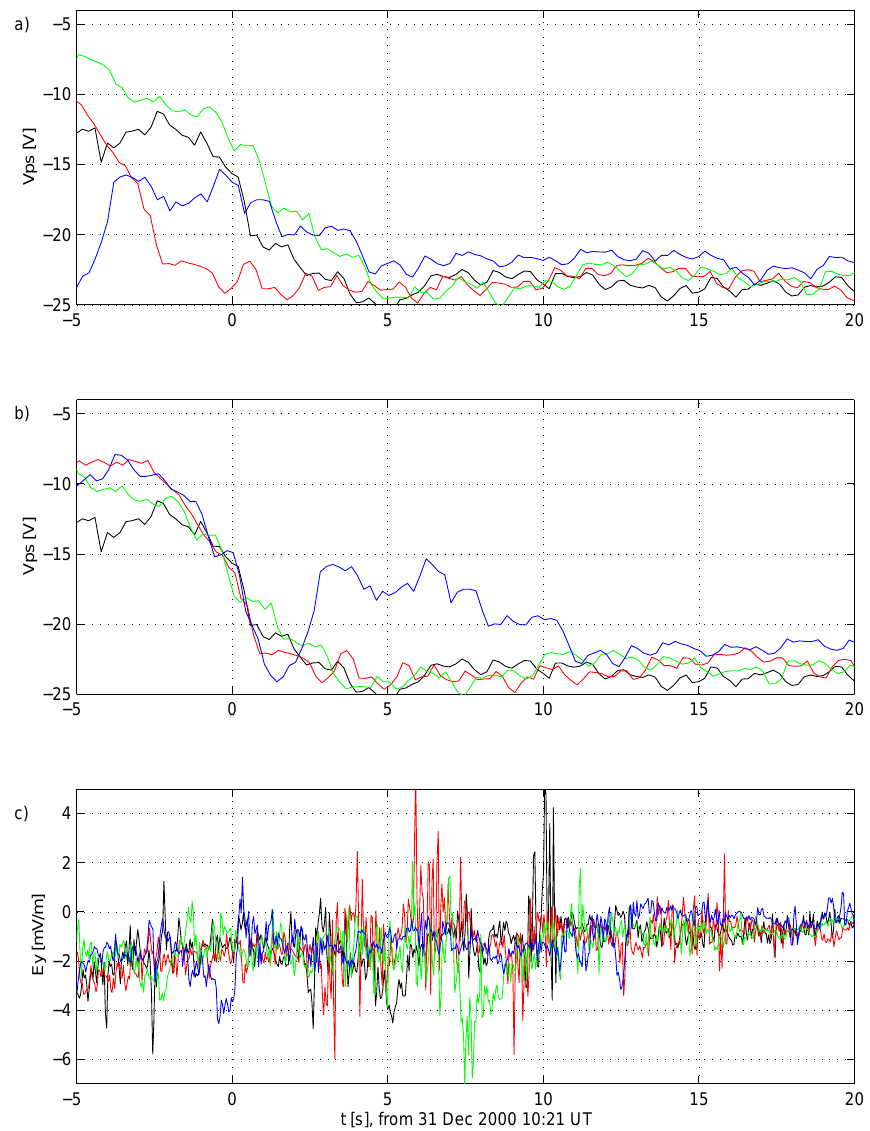
Fig. 8. (a) The potential v ps from 10:21:00 UT on 31 Decemeber 2000, for all four Cluster satellites (1: black; 2: red; 3: green; 4: blue), (b) The same signals, but shifted in time to correspond to a common moving magnetopause frame. (c) The E y component of the electric field for all four satellites, shifted as in panel